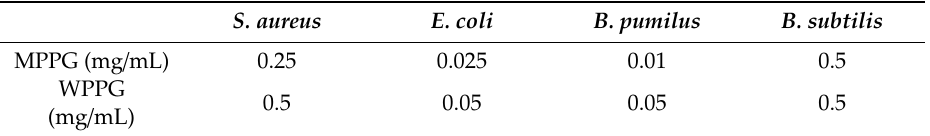
Table 5. Minimal inhibitory concentrations (MIC) of purified